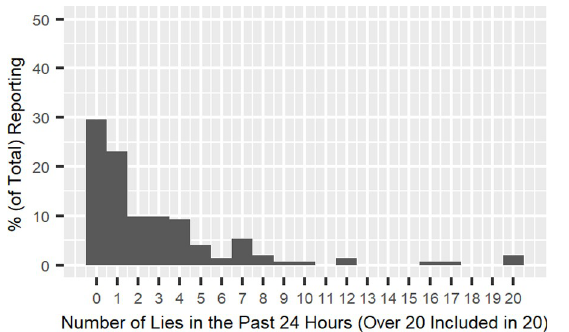
Fig 3. Total number of lies reported by low-confidence participants.